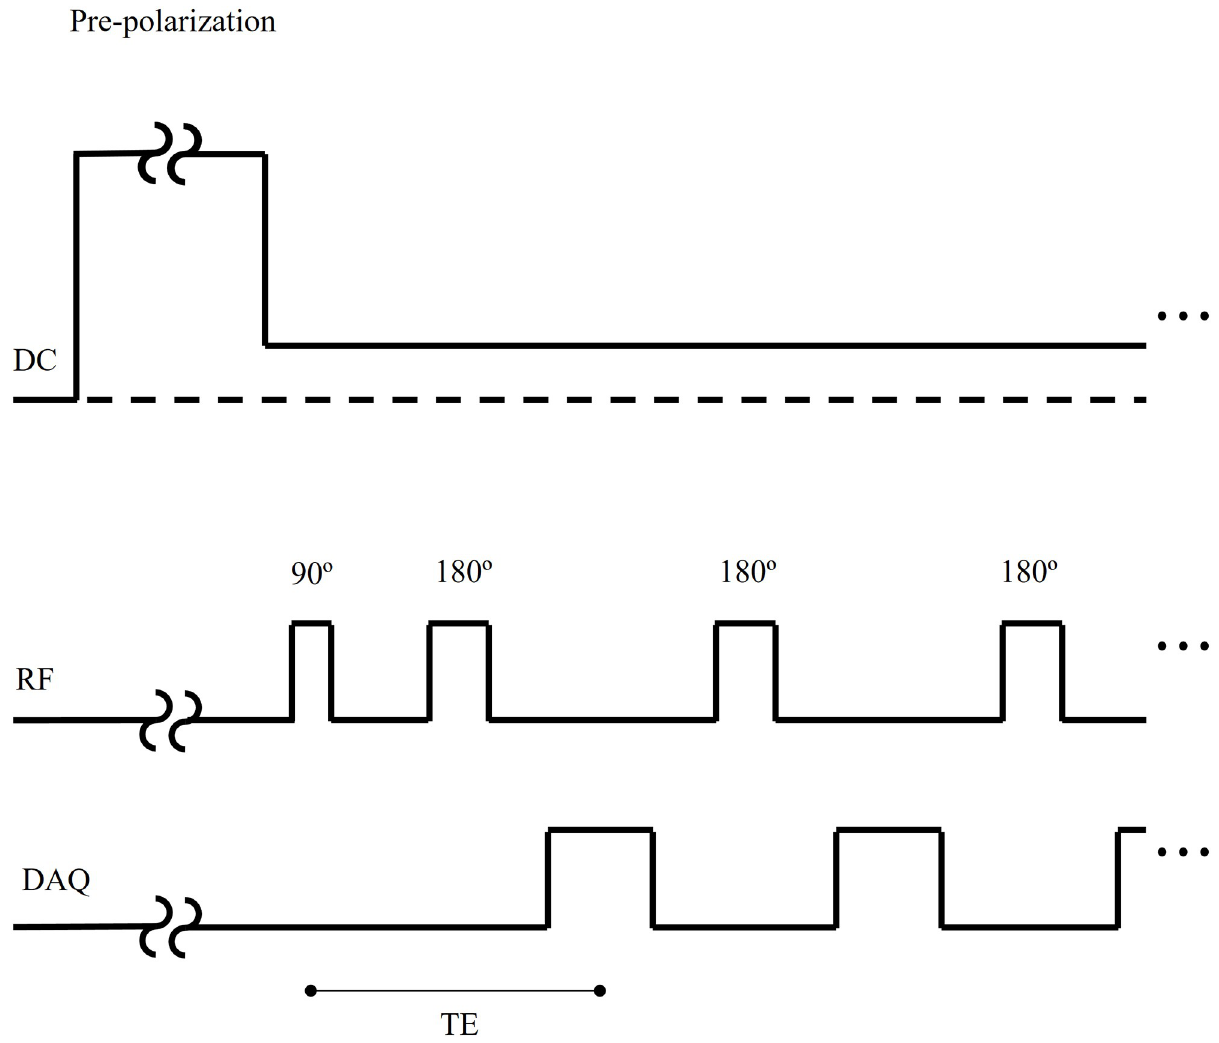
Fig 6. A spin-echo sequence with pre-polarization.